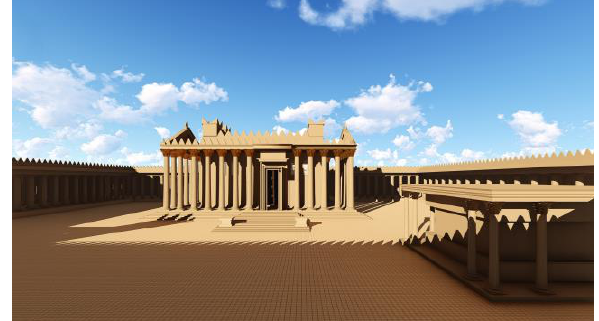
Figure 11. Great Temple of Bel as it was in Roman